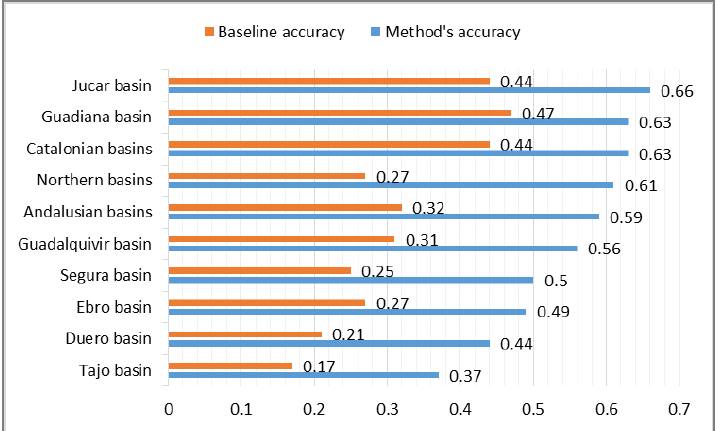
Figure 6. Evaluation results for geographic areas. The graphic shows the values obtained for the baseline accuracy (orange) and for our method’s accuracy